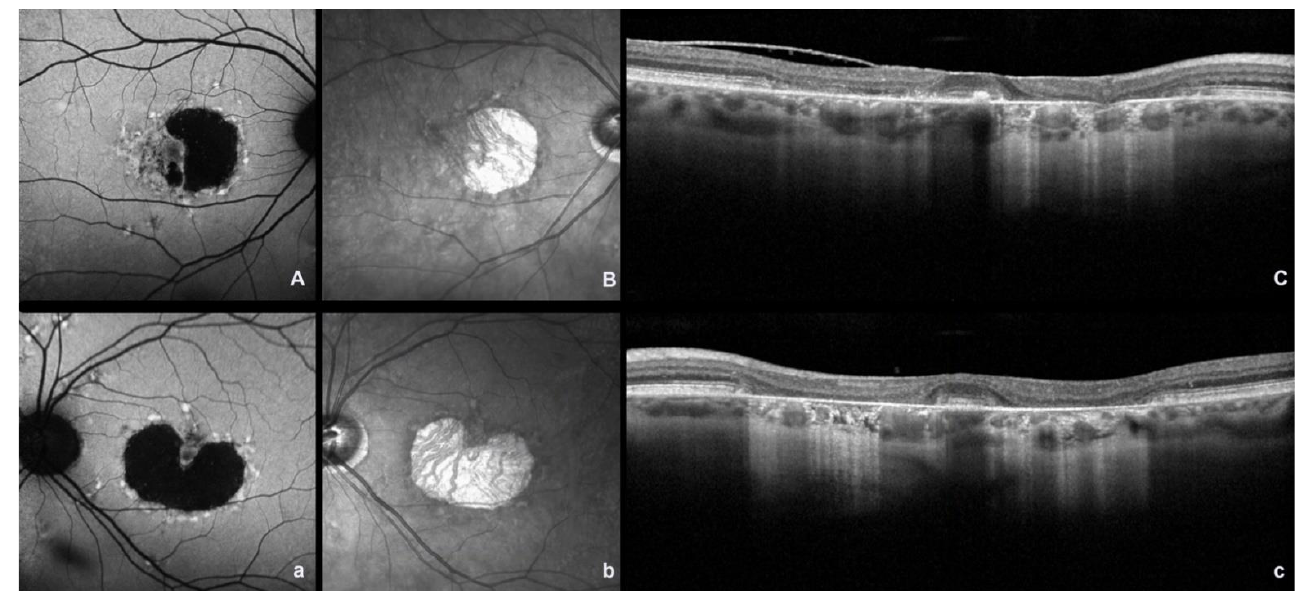
Figure 2. Fundus autofluorescence (FAF), near-infrared reflectance (NIR), and spectral domain optical coherence (SDOCT) images in a patient with bilateral molecularly confirmed ABCA4 Stargardt disease in an advanced stage. ( A , a ) FAF image showing a diffuse area of macular hypoautofluorescence with surrounding hyperautofluorescenct flecks; ( B , b ) NIR image showing a central macular hyporeflective area (atrophy area) surrounded by dotted hyperreflectivity (flecks); ( C , c ) SDOCT scan showing the absence of the outer retinal layer with diffuse backscattering (uppercase and lowercase letters indicate the right and left eye, respectively).